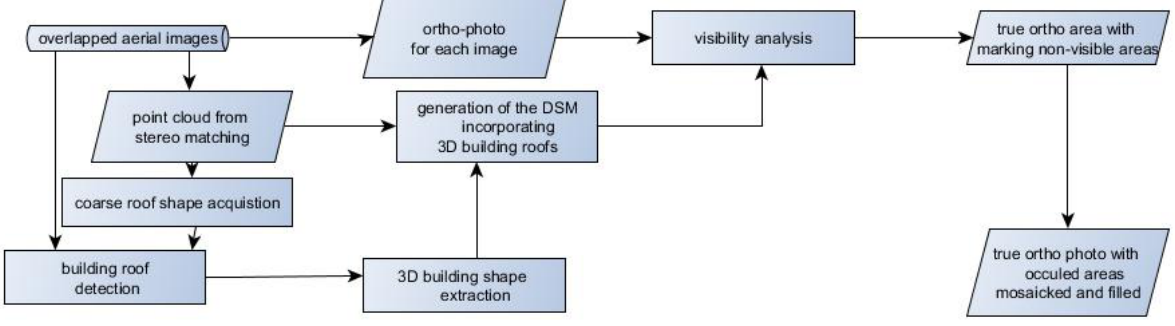
Figure 1: The entire processing of producing true orthophoto.